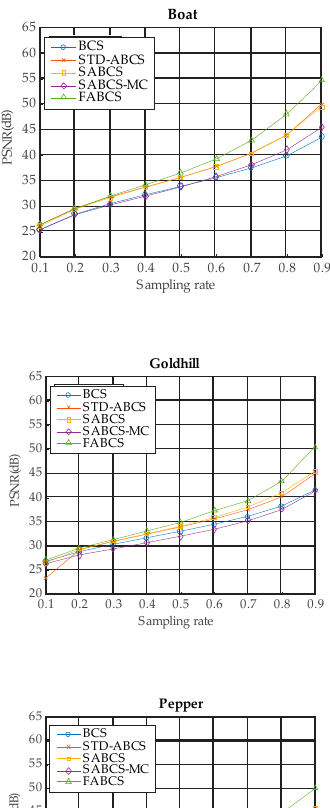
Figure 11. The experimental results for a block size of 16 × 16.